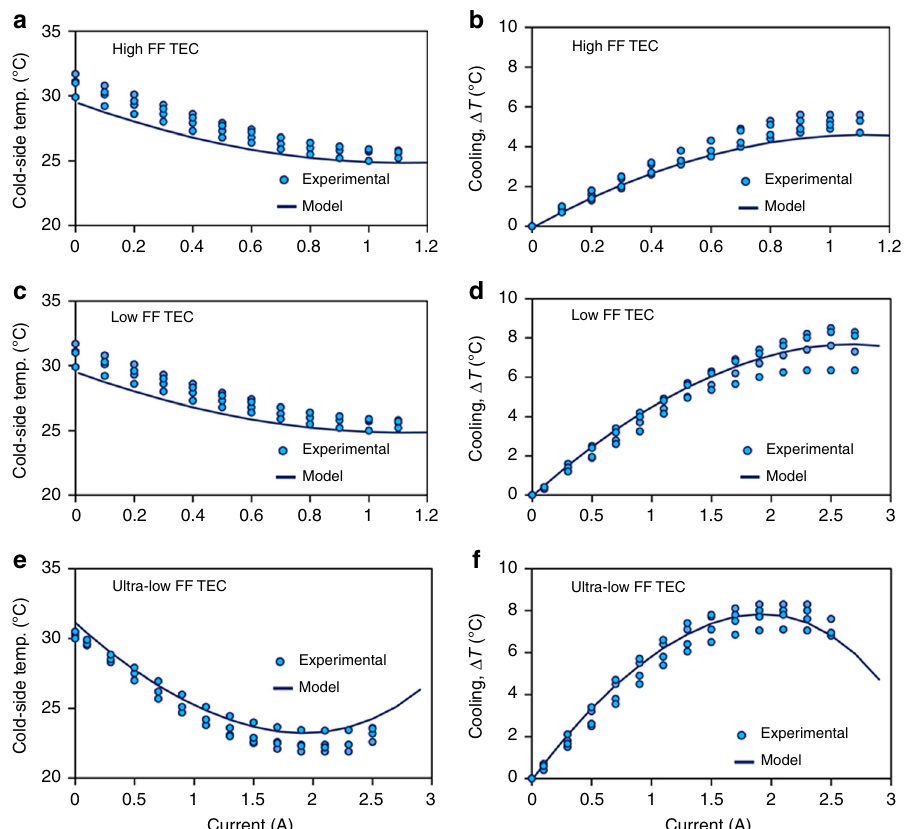
Fig. 6 Cold-side temperature and cooling versus electric current. a , b High-FF TEC, c , d low-FF TEC, e , f Ultra-low FF TEC. Circles illustrate the experimental data, whereas solid lines show the modeling results (obtained with h skin = 100 W m − 2 K − 1 ). The ultra-low FF TEC module results in 1.6 times higher cooling than the high-FF TEC